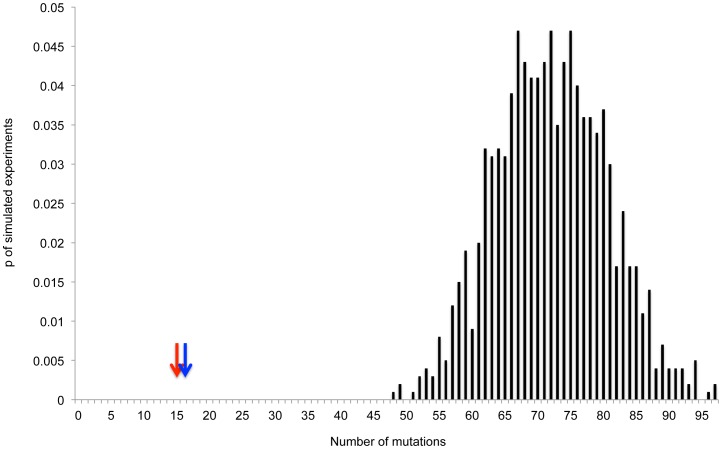
Actual number of observed mutations in rifampicin resistant and nalidixic acid resistant starved genomes is much smaller than expected within HMS (hypermutating cell subpopulation) cells.Drawn is the distribution of the numbers of mutations we would expect to find in 1000 simulated experiments in which we sequence 15 HMS genomes, and each HMS genome is expected to accumulate on average 4.82 mutations (calculated based on a 25-fold increase in mutagenesis across the entire starved population and an HMS size of 10%). The arrows represent the numbers of mutations we actually observed in 15 fully sequenced starved rifampicin (Red), or nalidixic acid (Blue) resistant genomes.